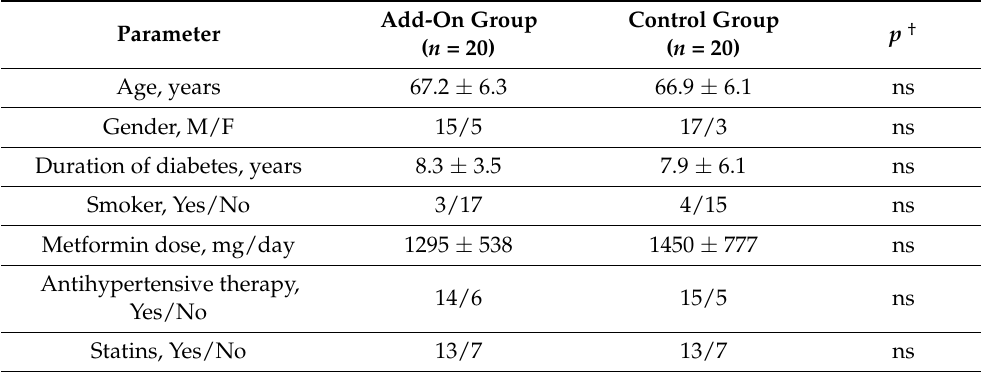
Table 1. Baseline clinical characteristics of the intervention and control groups. For continuous data, values are presented as mean ±